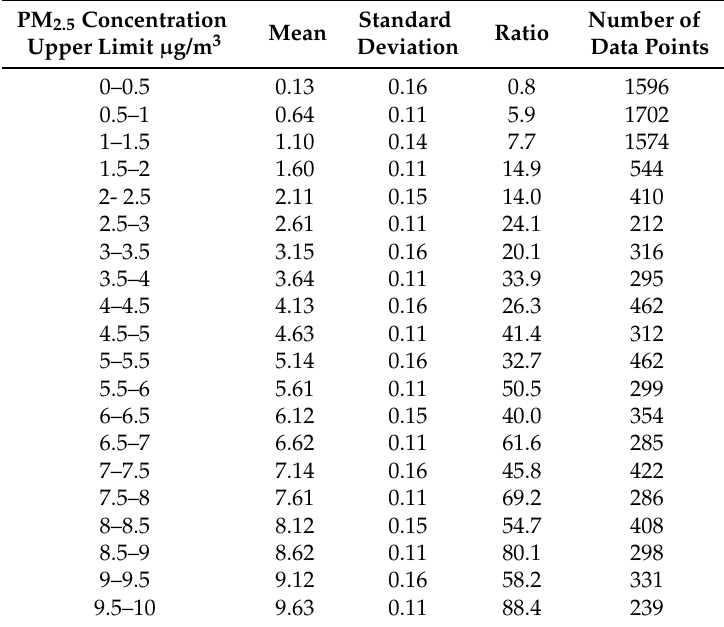
Table A4. PM 2.5 concentration range, the mean and the standard deviation of the PM 2.5 concentrations within that range, the ration of the mean and the standard deviation and the number of data points used for the calculations for Plantower PMS5003. The Lower limit of detection with Wallace et al. [65] method is defined as the PM 2.5 concentration above which the ratio is > 3.